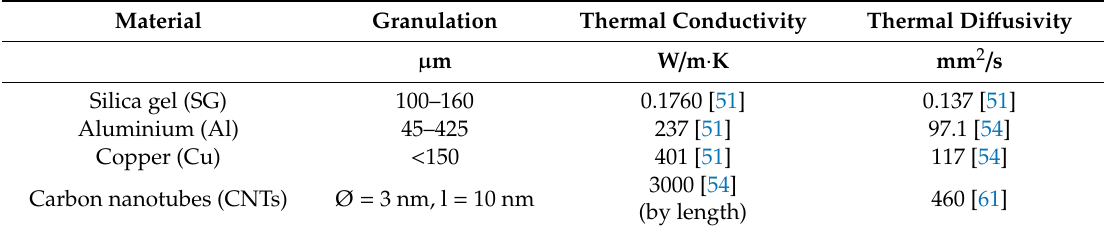
Table 4. Physical properties of the used Table 3. Sample compositions for measurement. CNTs: Carbon nanotubes.